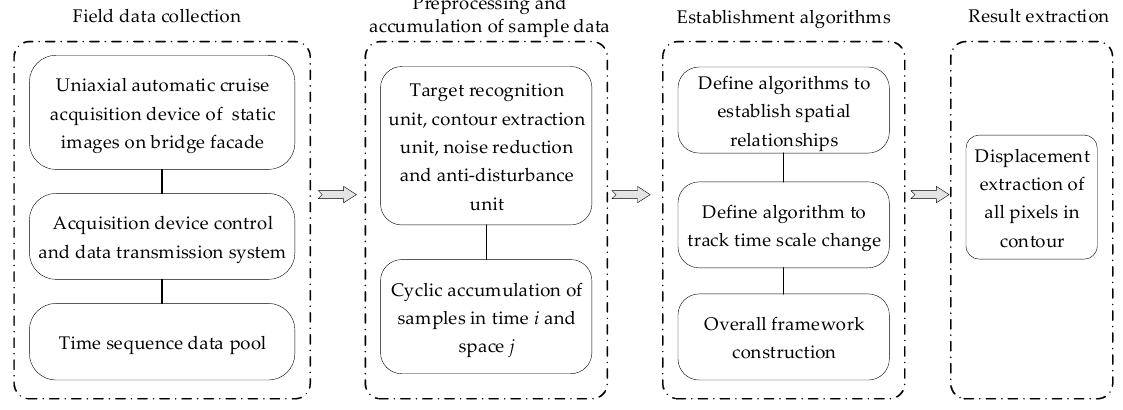
Figure 2. The workflow of the intelligent NRS system.